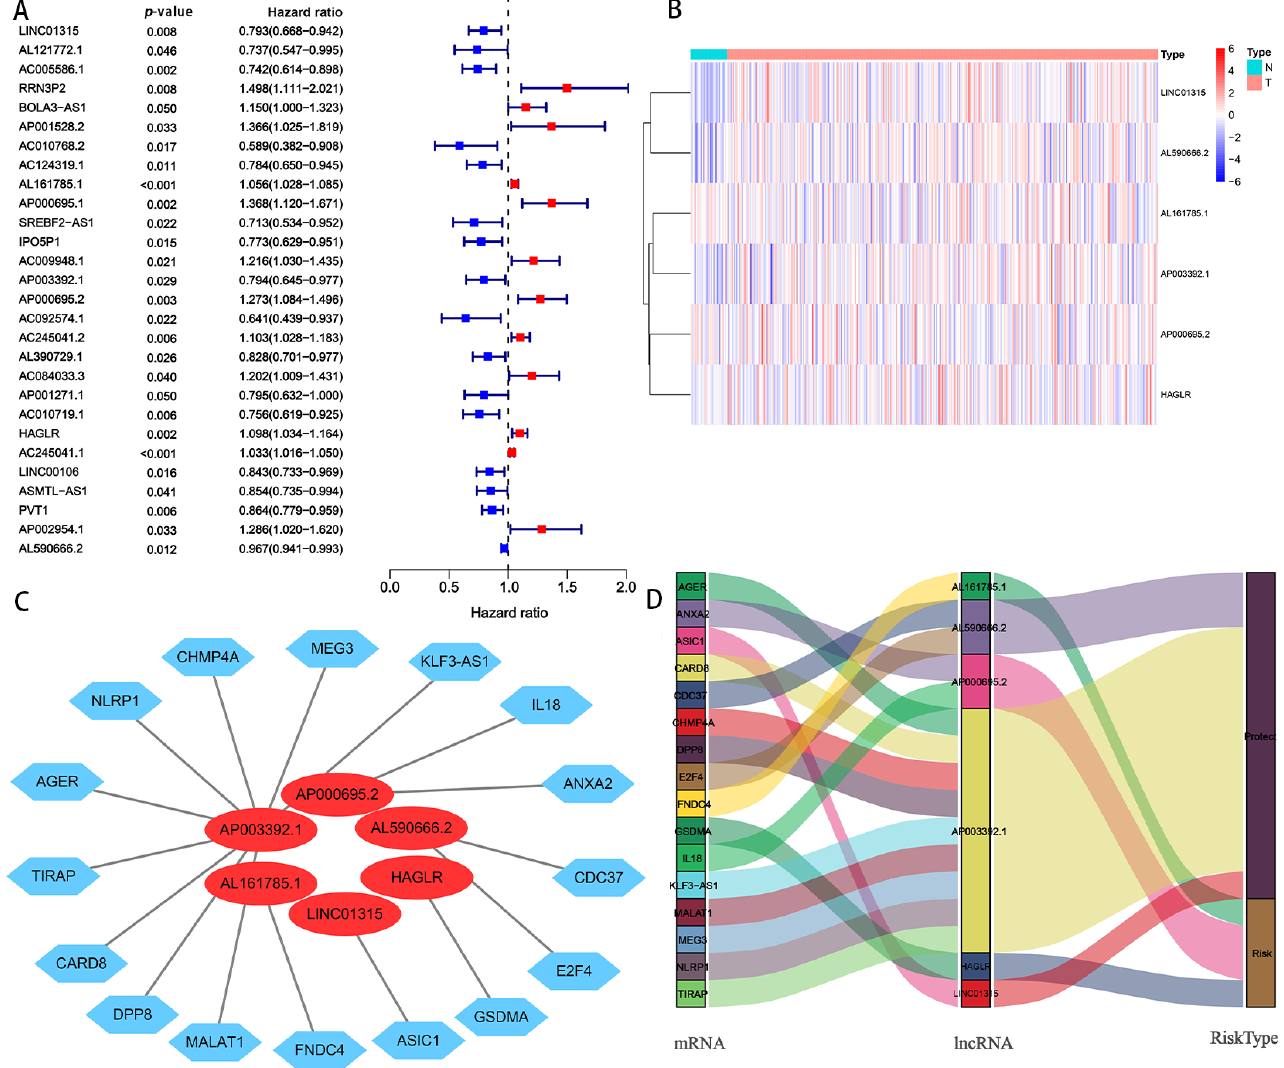
Figure 2. Screening of PRlncRNAs, which were significantly associated with a prognosis of GC. ( A ) A univariate Cox proportional hazards analysis revealed the HR (95% CI) and p -value of the selected lncRNAs in the forest plot. ( B ) Heat map of the differential expression of six PRlncRNAs with a prognostic value in regard to gastric cancer and normal tissues. ( C ) The prognostic pyroptosis-related lncRNA co-expression network. ( D ) The visualized Sankey diagram. N: nomal; T: tumer; NLRP1, CHMP4A, MEG3, KLF3-AS1, IL 18, ANXA2, CDC37, E2F4, GSDMA, ASIC1, FNDC4, MALAT1, DPP8, CARD8, TIRAP, AGER: Pyroptosi s -related mRNAs.